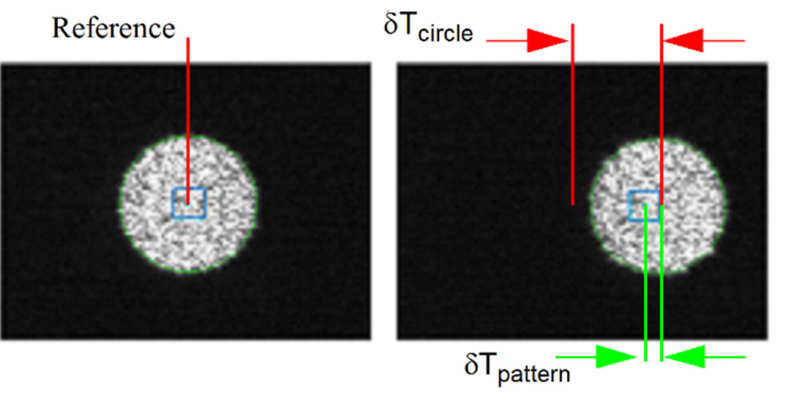
Figure 18. A rotation around axis O M of the manipulator causes the camera to translate and rotate and the image of the APSS to translate by δ T circle . In addition, the rotation causes a speckle point to move inside the image of the APSS by δ T pattern